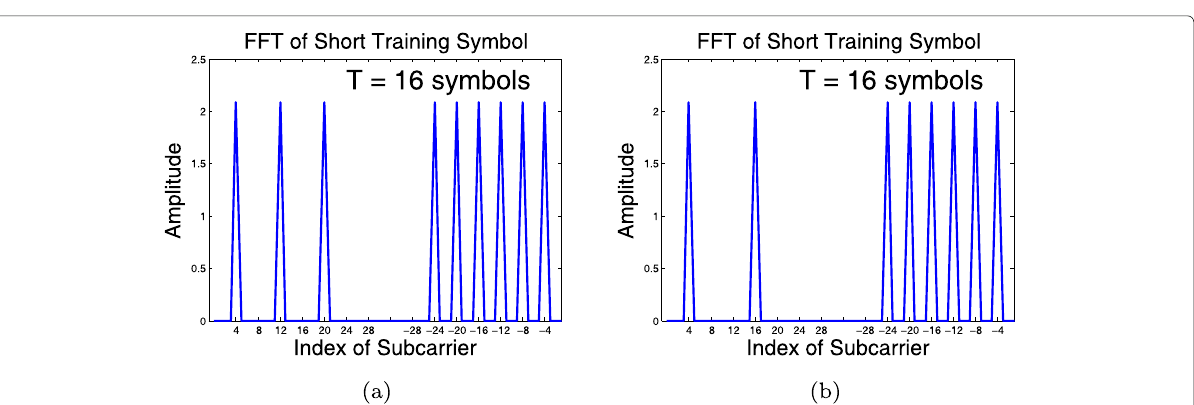
Fig. 7 Observation 3: filtering some non-contiguous subcarriers in one sideband out does not change period of STS. a Filter subcarrier No. 8, 16, 24. b Filter subcarrier No. 8, 12, 20, 24